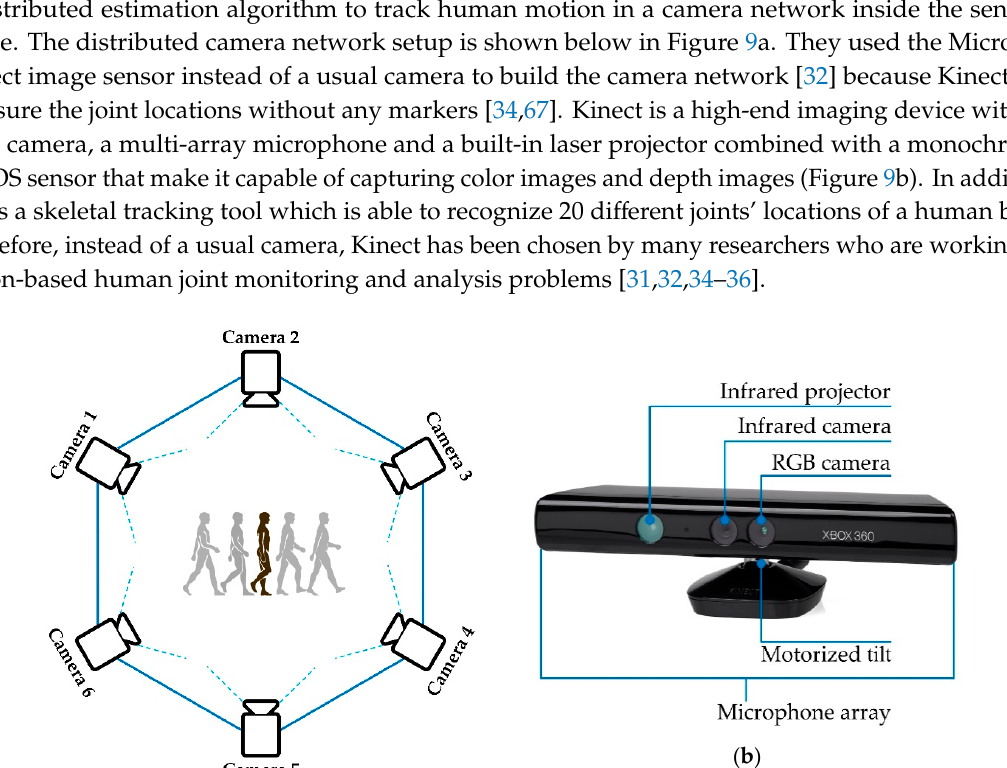
Figure 8. Block diagram of imaging-based human skeletal tracking.